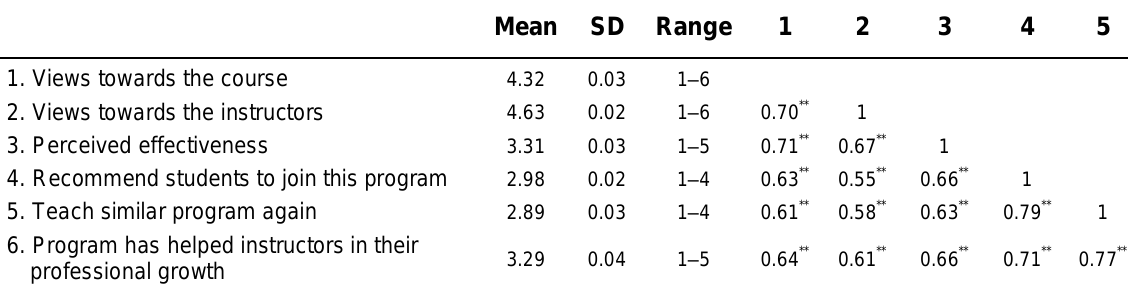
Means, Standard Deviations, and Intercorrelations of Different Aspects of I mplementers’ Subjective Outcome